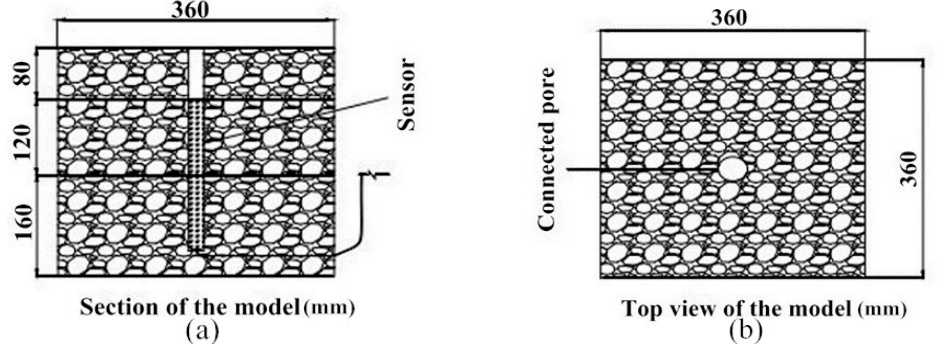
Figure 3. (a) Section of the model, (b) Top view of the model.